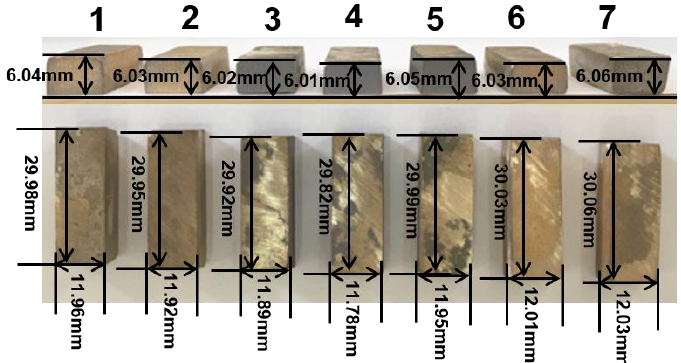
Figure 5. The images of microwave pressureless sintered samples: the sintering conditions of samples Nos. 3, 4 and 5 were 880 ◦ C/375 MPa/35 min, 900 ◦ C/375 MPa/35 min, and 920 ◦ C/375 MPa/ 35 min, respectively; the sintering conditions of samples Nos. 3, 2, and 1 were 880 ◦ C/375 MPa/ 35 min, 880 ◦ C/450 MPa/35 min, and 880 ◦ C/525 MPa/35 min, respectively; the sintering conditions of samples Nos. 3, 6, and 7 were 880 ◦ C/375 MPa/35 min, 900 ◦ C/375 MPa/45 min, and 920 ◦ C/ 375 MPa/55 min,